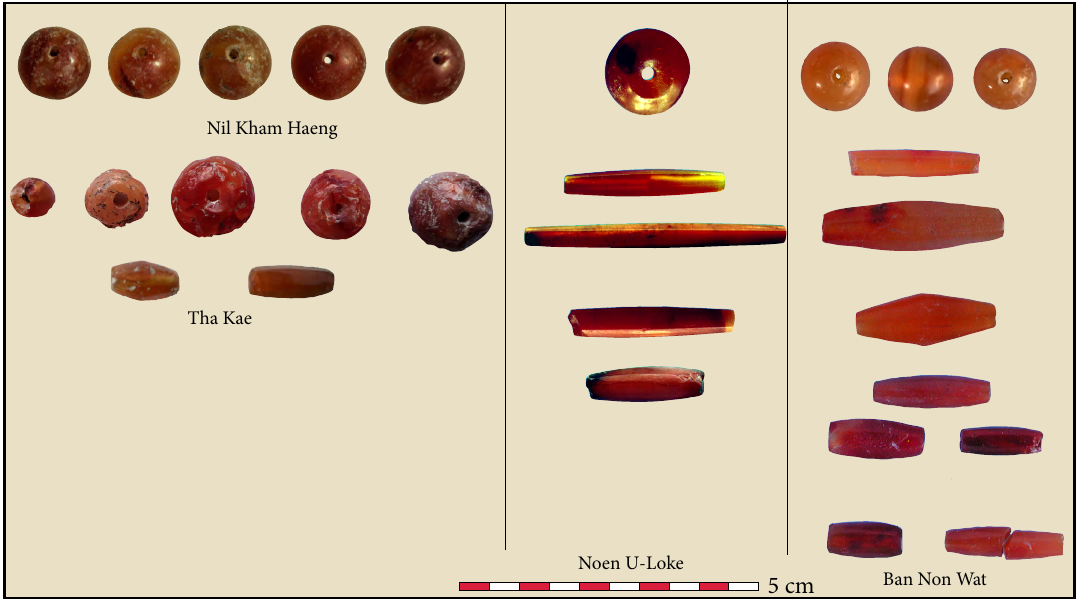
Fig. 12: Carnelian beads from Iron Age contexts in the Lopburi region and the Upper Mun